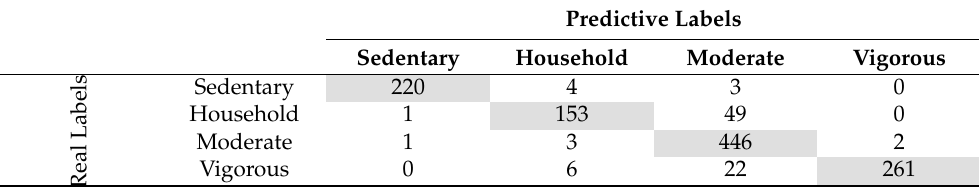
Table 4. The Confusion matrix of the four activity intensity labels among SMO algorithm.